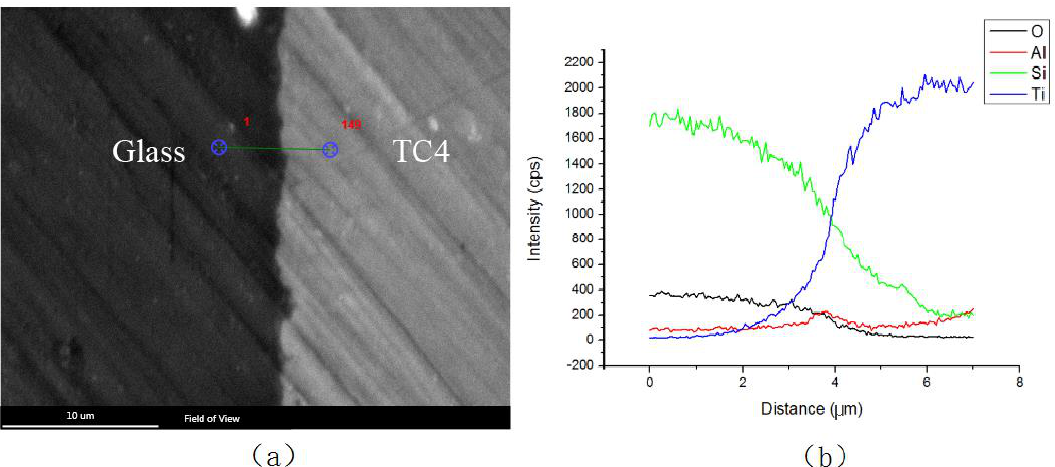
Figure 11. Scanning-electron-microscope ( a ) micrographs of cross-section and ( b ) element distribution along scan line.